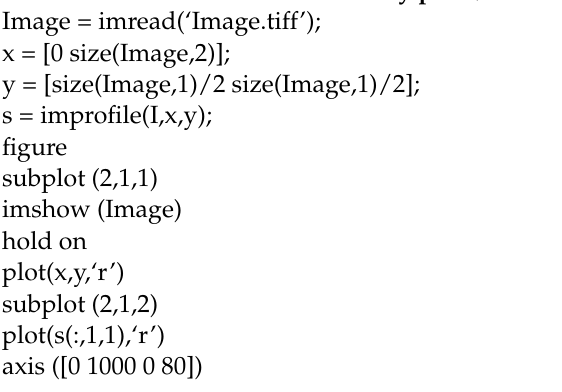
MATLAB Code for surface intensity plot (used in Figure 2b) Image = imread(‘Image.tiff’);